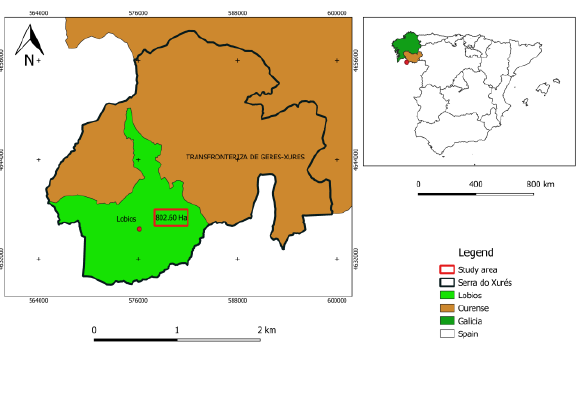
Figure 1. Location of study